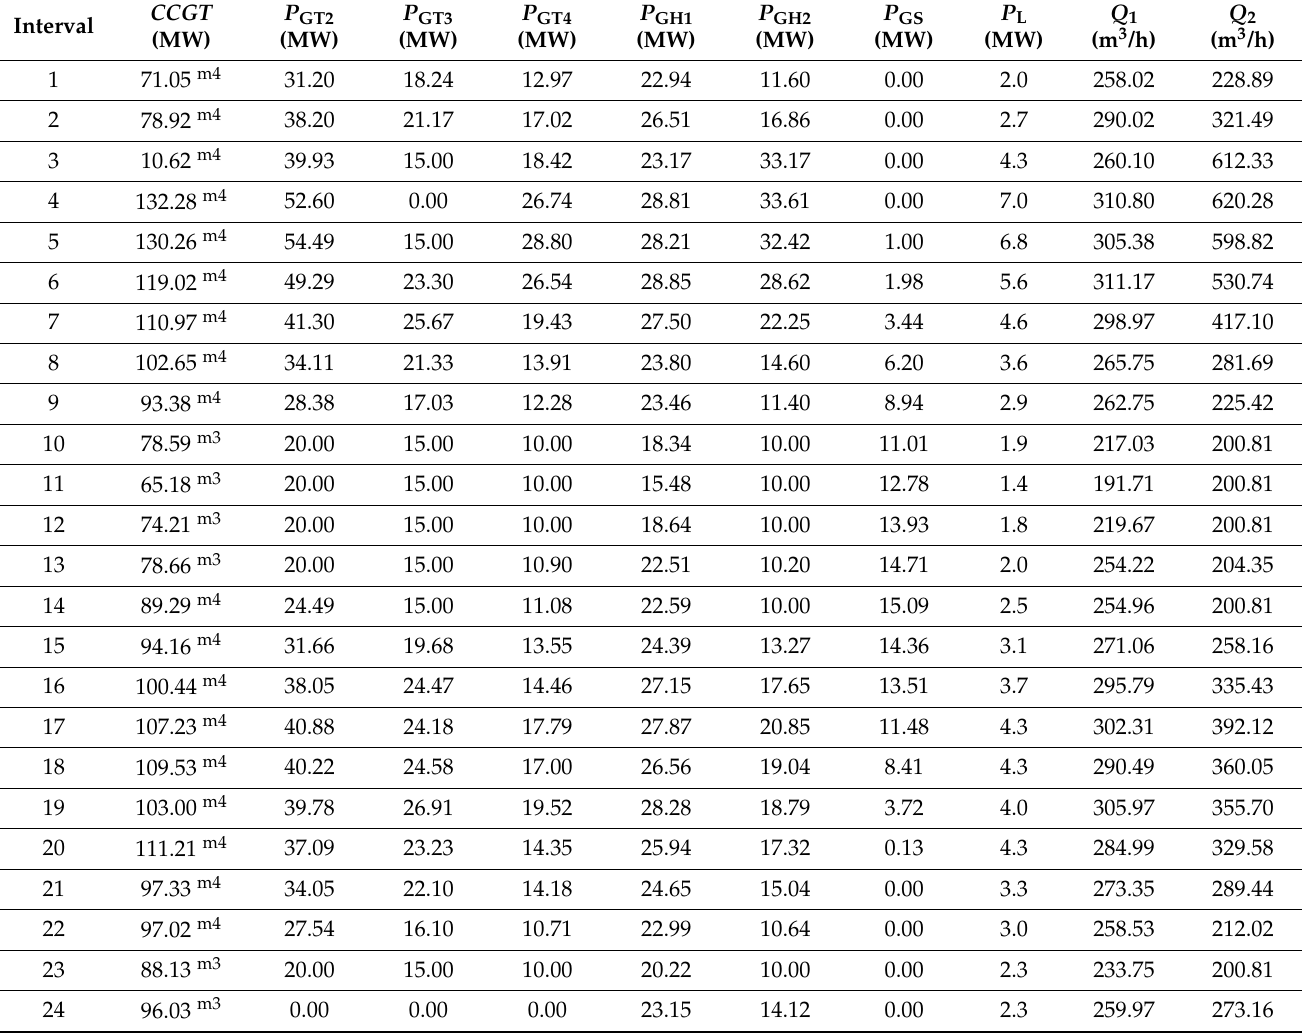
Table 10. Optimal generation scheduling using SAGA for case